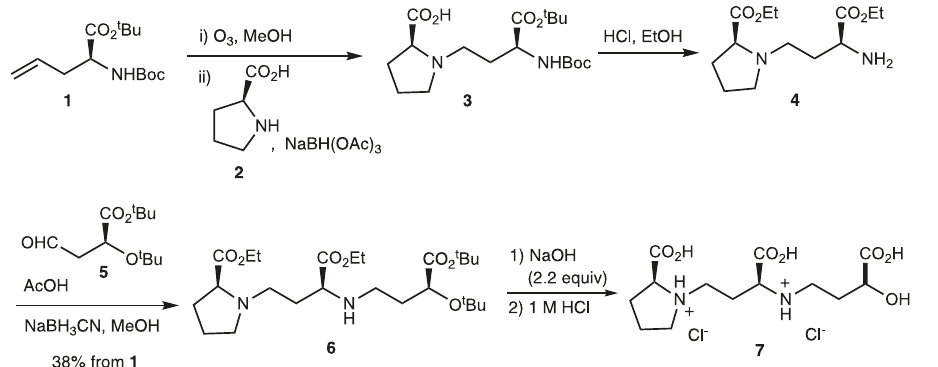
Fig. 7 Synthesis of PDMA. PDMA·HCl salt 7 was synthesized from allylglycine 1 with an overall yield of 38%. Puri fi cation by column chromatography was performed once. Boc tert -butoxycarbonyl, t Bu tert -butyl, NaBH(OAc) 3 sodium triacetoxyborohydride, NaBH 3 CN sodium cyanoborohydride, AcOH acetic